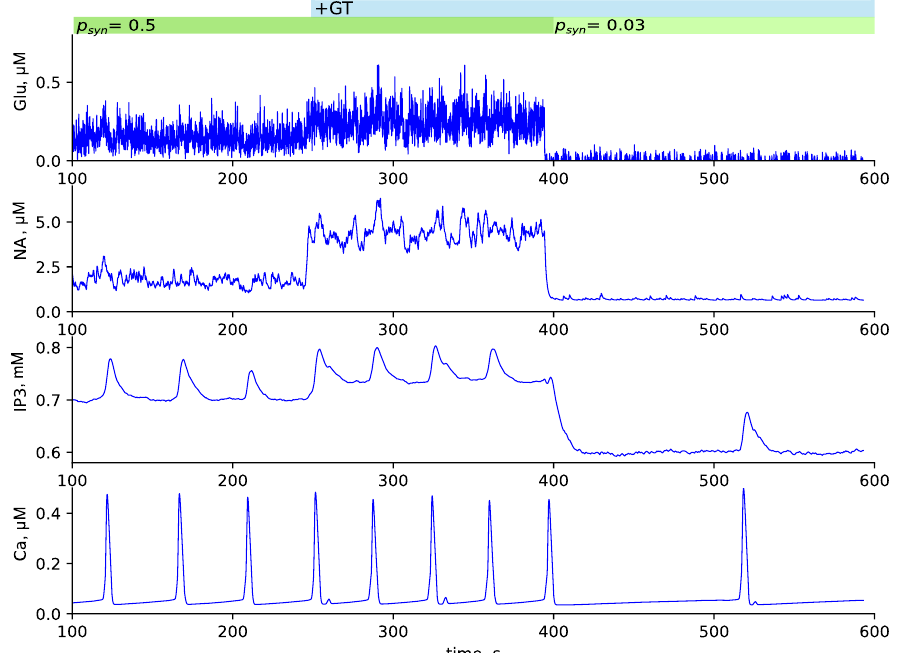
Figure 6. Testing GANE pathways. Gliotransmitter effect (switched on at t = 250s) with subsequent reduction in synaptic drive at t = 400s. Parameter set 4 was